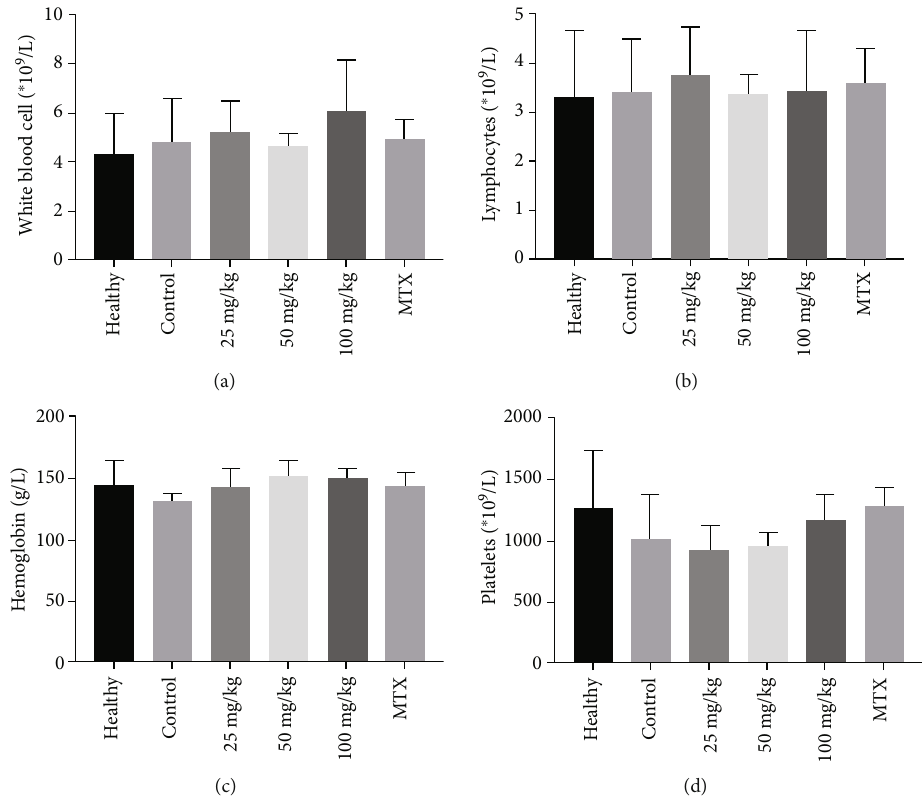
Figure 5: E ff ects of matrine and MTX on routine blood analysis of CIA rats. Serum concentrations of white blood cells, lymphocytes, hemoglobin, and platelets were tested after treatment: (a) white blood cells; (b) lymphocyte; (c) hemoglobin; (d) platelets. Healthy: healthy group; control: CIA control group; 25 mg/kg: low dosage matrine group; 50 mg/kg: medium dosage matrine group; 100 mg/kg: high dosage matrine group; MTX: 2 mg/kg methotrexate